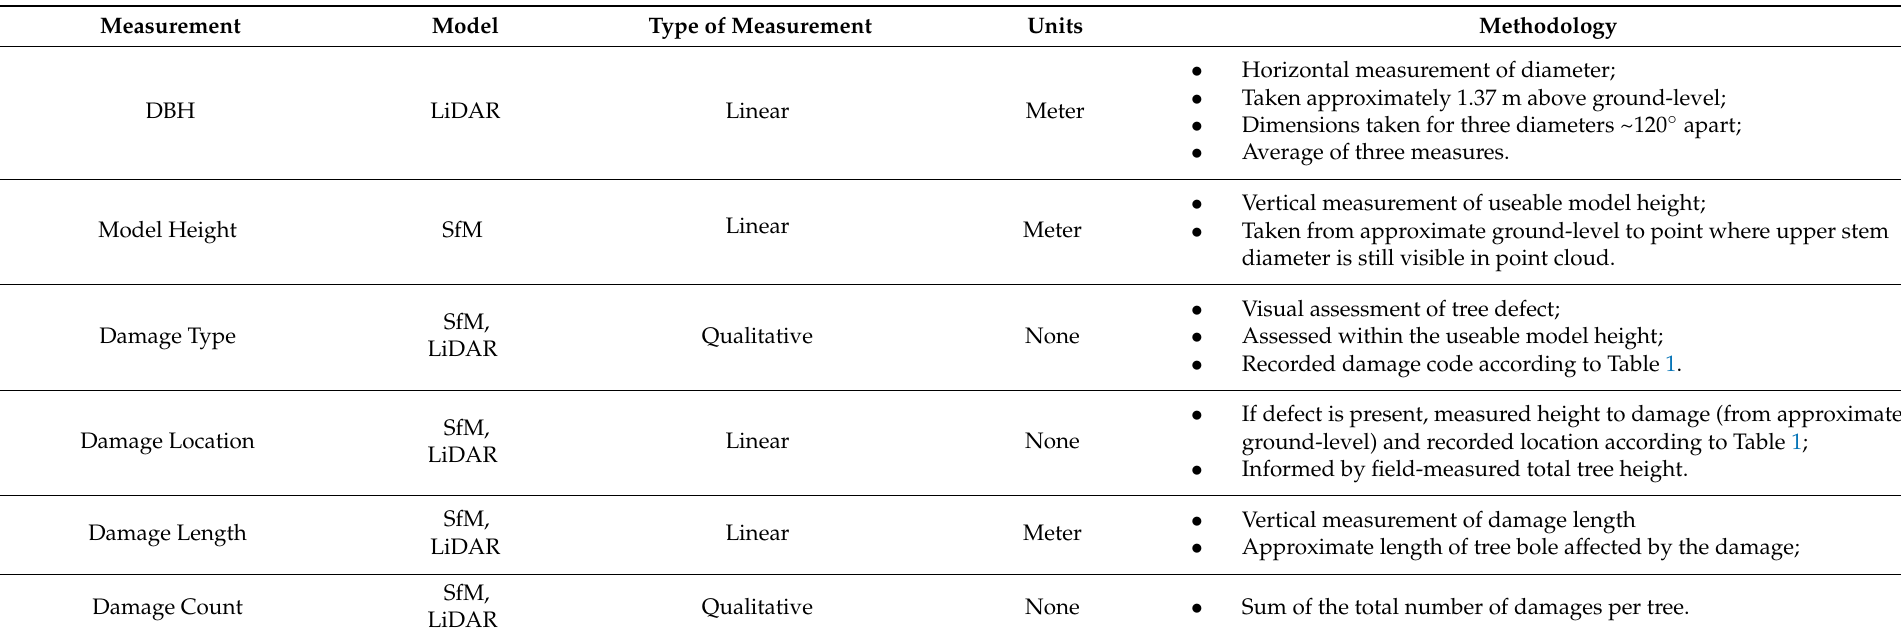
Table 2. Descriptions of point cloud measurements derived from handheld LiDAR and Structure from Motion (SfM)